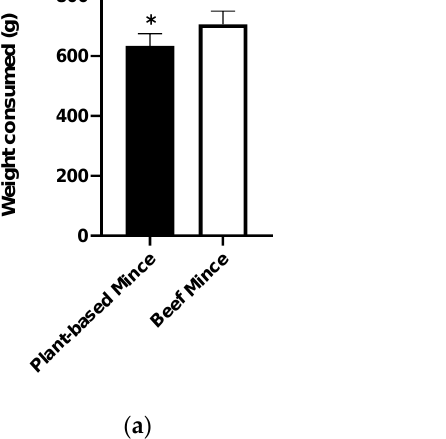
Figure 1. Participant Flow.